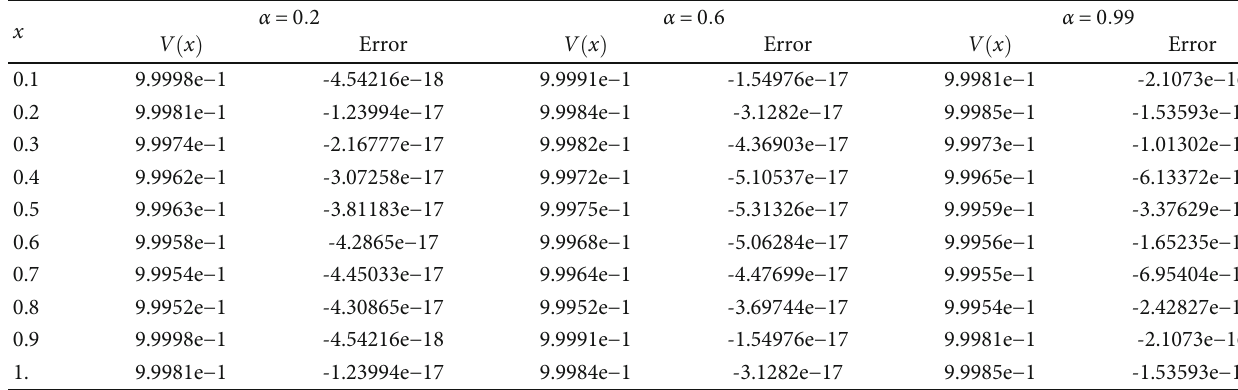
= 0 : 001 are fi xed. p